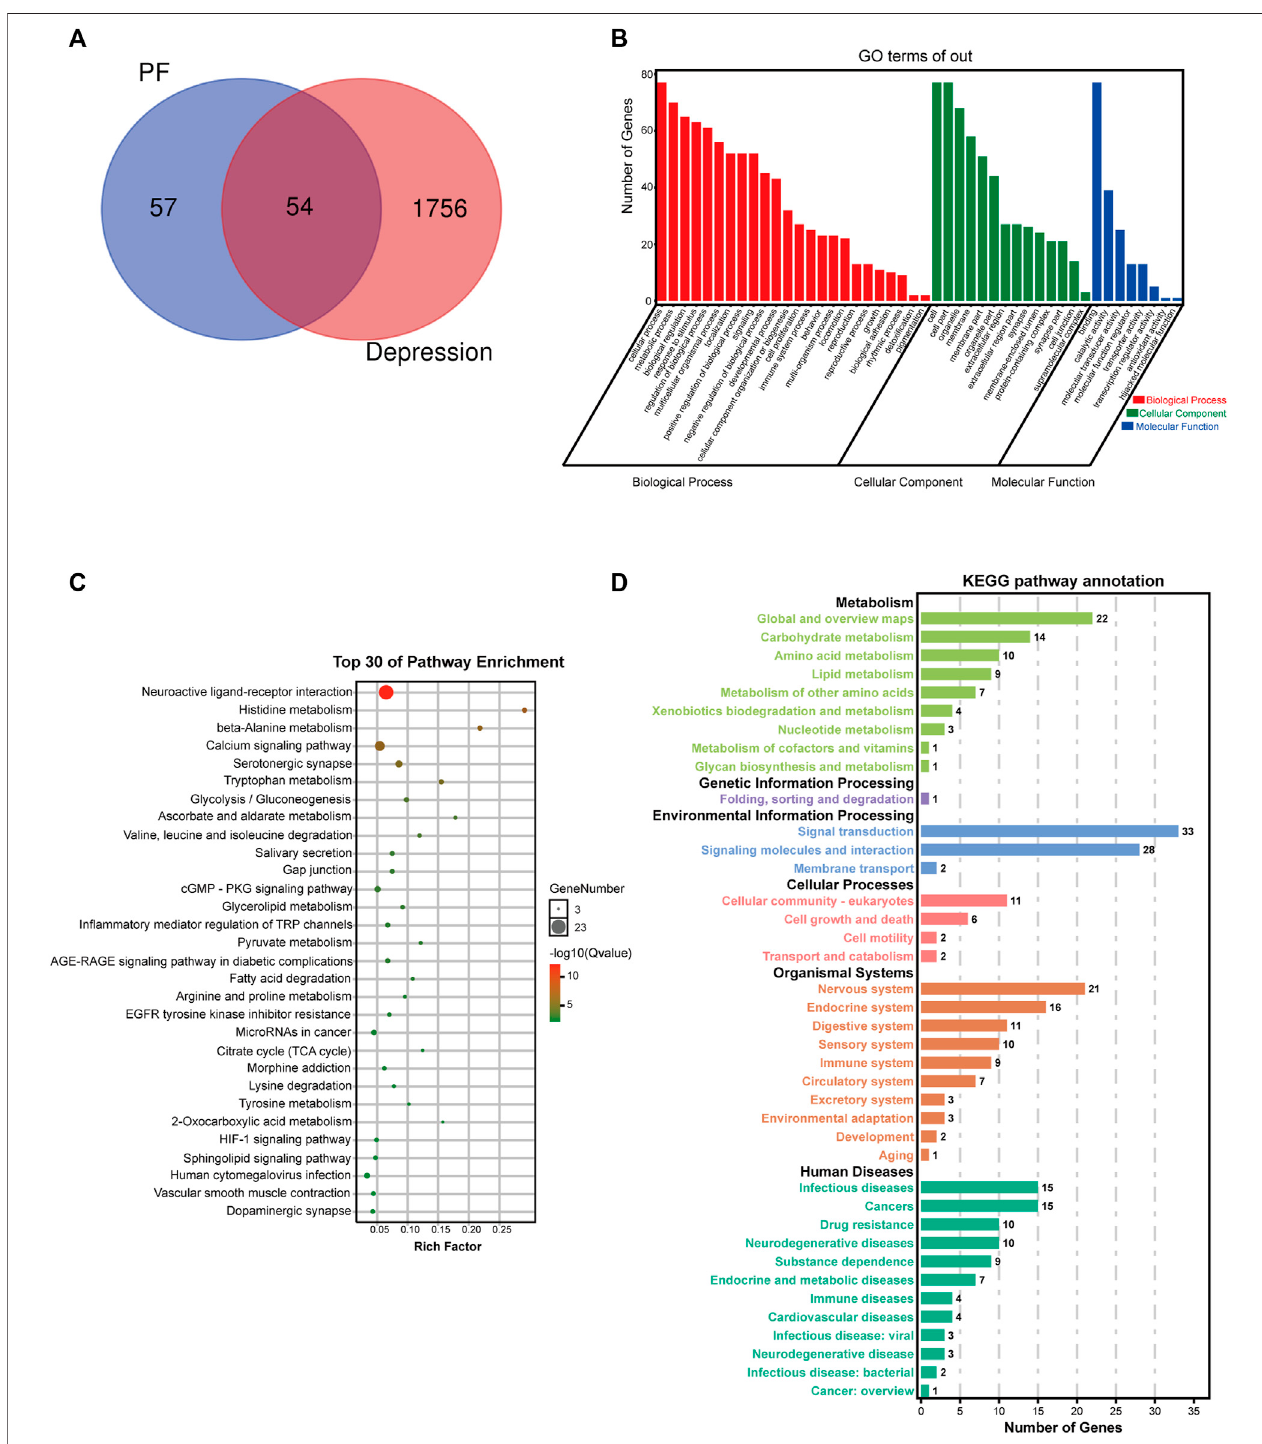
FIGURE 6 | Potential target network analysis. (A) Venn diagram of potential targets. (B) GO analysis of potential targets. (C) Top 30 KEGG pathways of potential targets. (D) KEGG pathway annotation.